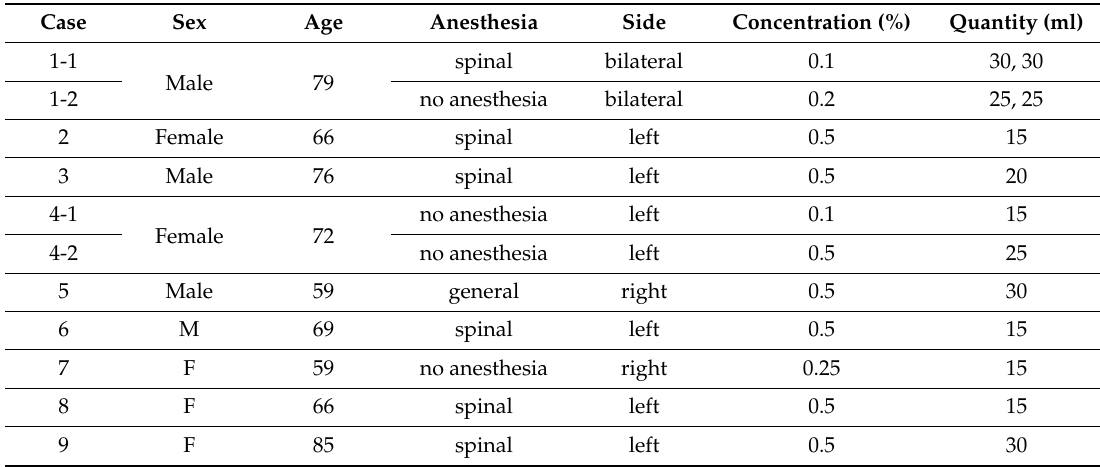
Table 1. Patient characteristics and contents of silver nitrate instillation